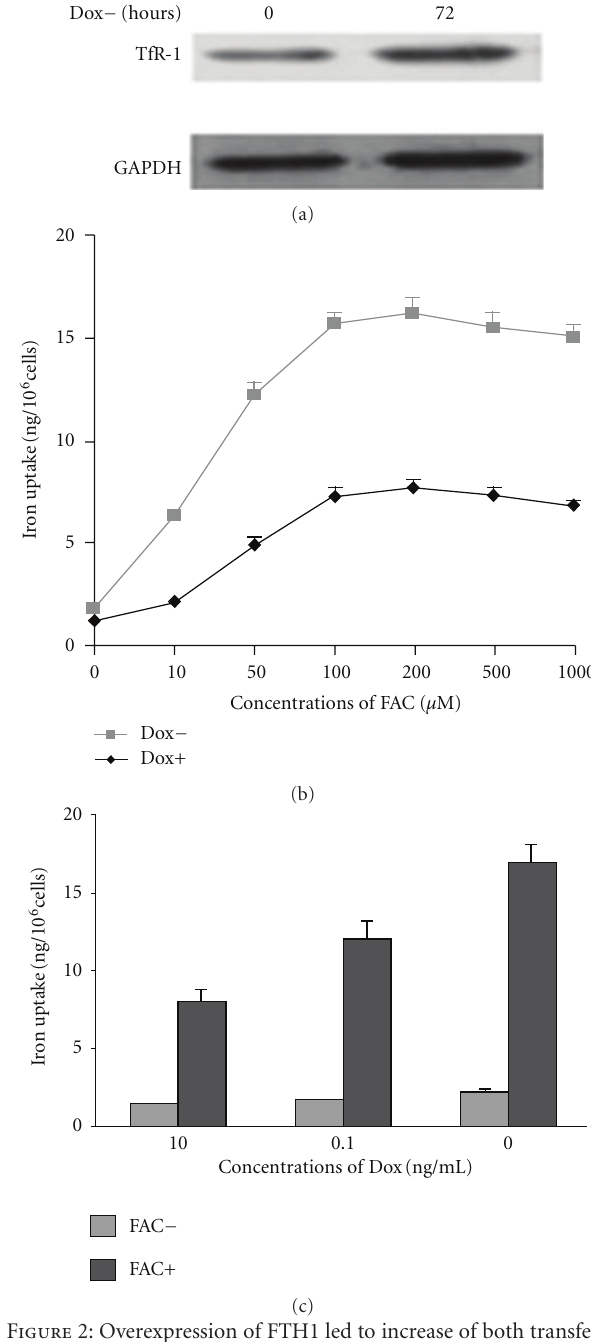
Figure 2: Overexpression of FTH1 led to increase of both transfer- rin receptor 1 (TfR-1) and intracellular iron content. (a) Western blot assay of TfR-1 expression induced by FTH1. B-7 cells grown in the presence of doxycycline (10ng/mL) (Dox+) were transferred to Fe containing medium (200 μ M FAC) in absence of doxycycline (Dox − ) followed by incubation for 72 h. (b, c) Quantification of intracellular iron content by ICP-MS. (b) B-7 cells were grown in the presence (Dox+) or absence (Dox − ) of doxycycline (10ng/mL) in the presence of FAC at di ff erent concentrations for 48h, (c) B-7 cells grown in the presence of doxycycline at various concentrations were incubated with (FAC+) or without (FAC − ) (200 μ M) for 48 h. Data were expressed as mean ± SD from 3 experiments. FAC, ferric ammonium citrate. ICP-MS, inductively coupled plasma atomic emission